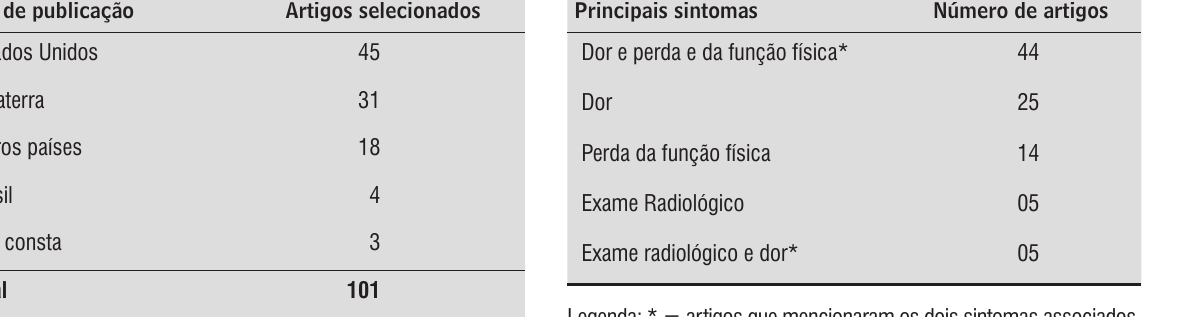
Legenda: * = artigos que mencionaram os dois sintomas associados. Fonte: Dados da